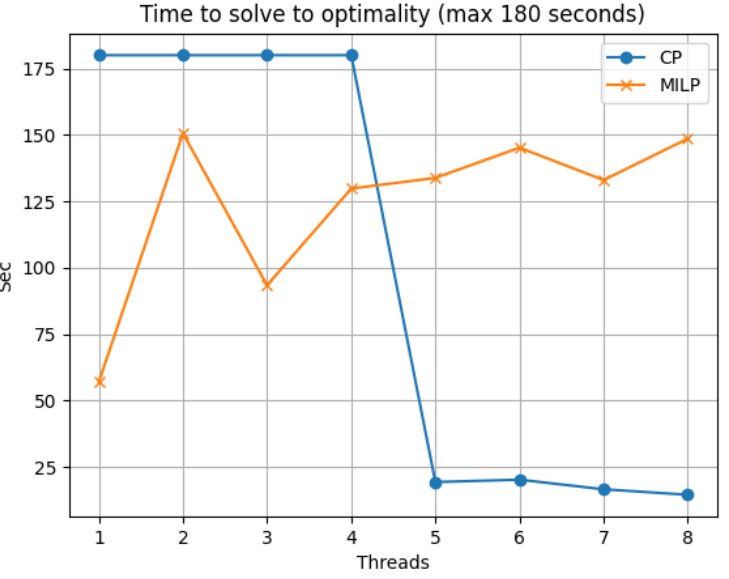
Figure 3. Time required by the MILP solver and by the CP solver with different numbers of threads (180 s maximum time)—instance eil101_0_0_1_2_1 from